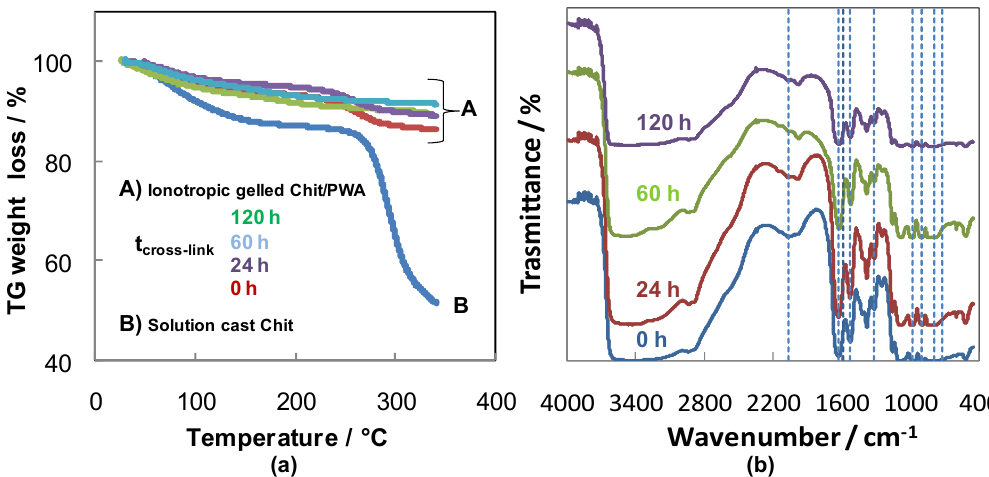
Figure 6. ( a ) TG under N 2 atmosphere and ( b ) FTIR analysis of composite Chit / PWA flat structures